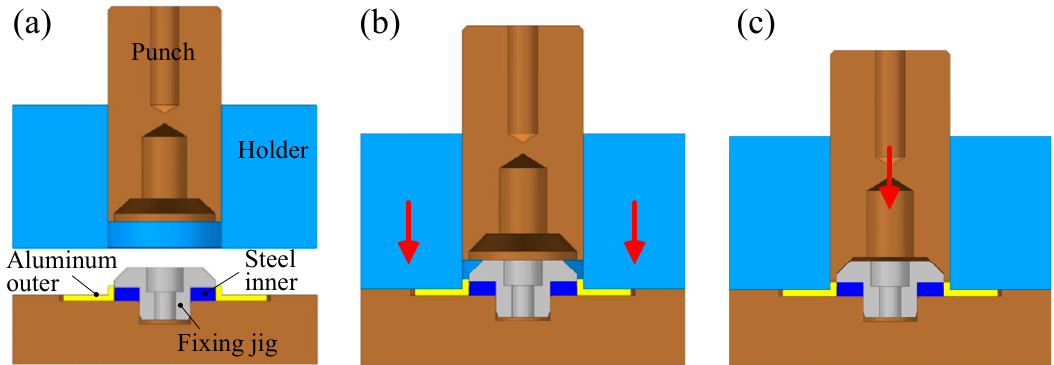
Figure 11. Die set and fabricated specimen: ( a ) die set; ( b ) specimen.